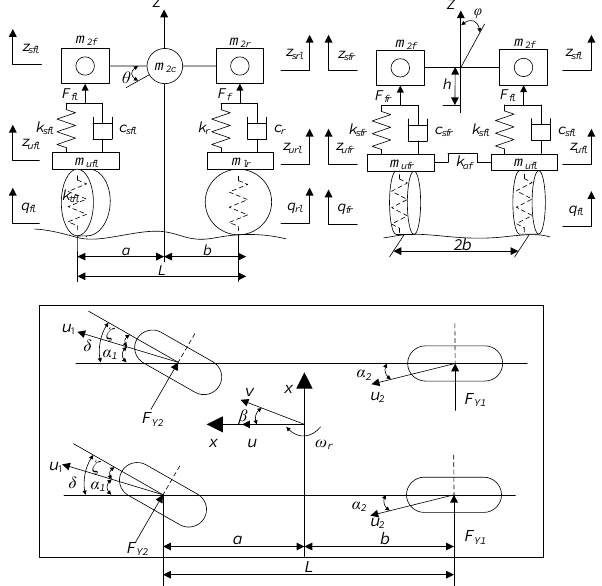
Figure 6. Automobile dynamic model with three degrees of freedom.